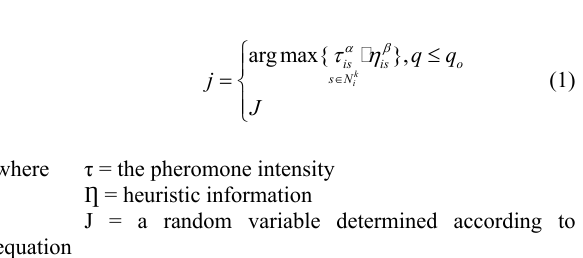
Table 8. Criteria weights of all bus